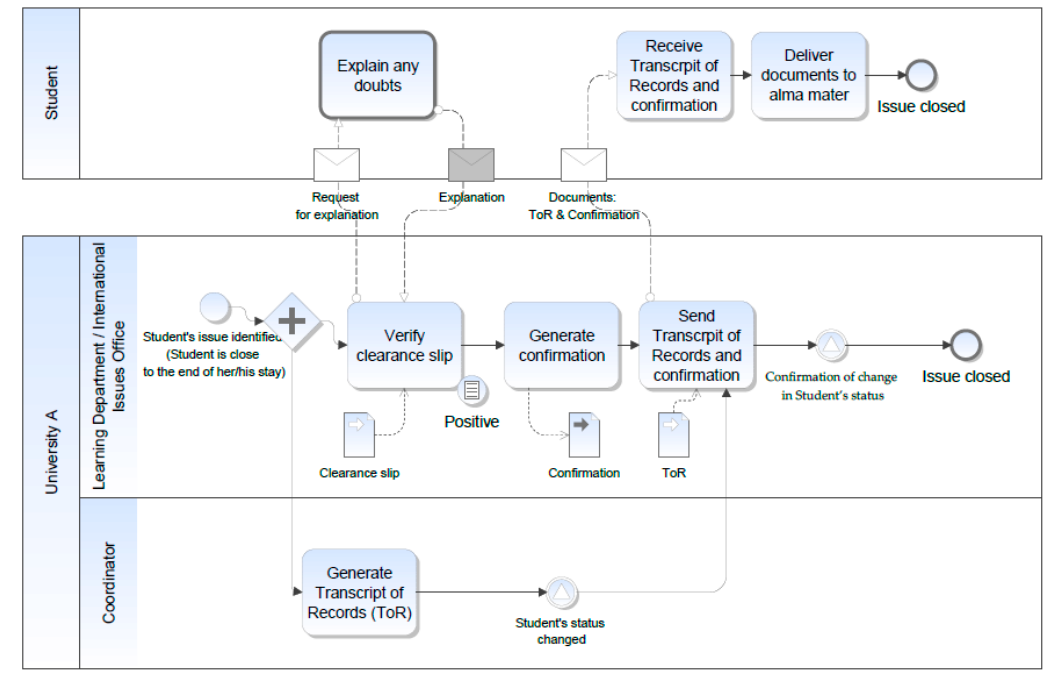
Figure 5. Map of the procedure of a student returning to his/her alma mater.